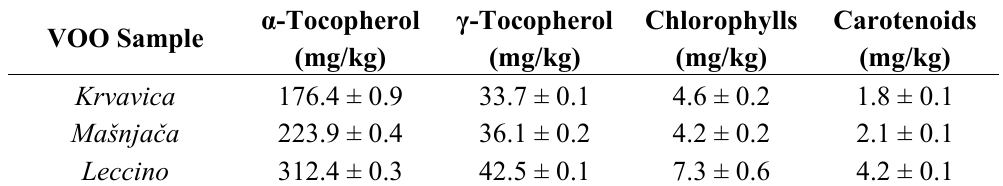
All values are expressed as mean of triplicate determinations ±